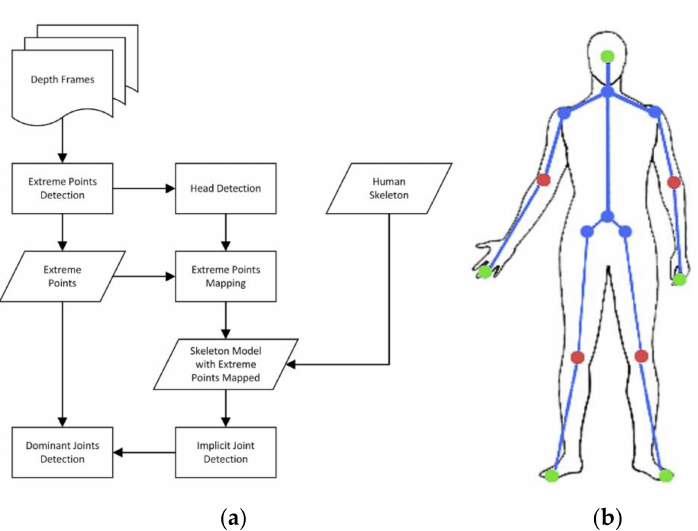
Figure 8. Geodesic distance is used to locate the positions of extreme points. ( a ) describes the overview of the workflow of the proposed method. ( b ) shows the skeleton model used in our method. The green dots represent the extreme points. Blue dots represent implicit joints (neck, waist, shoulders, and hips). Red dots represent dominant joints (elbows and knees). Figure from